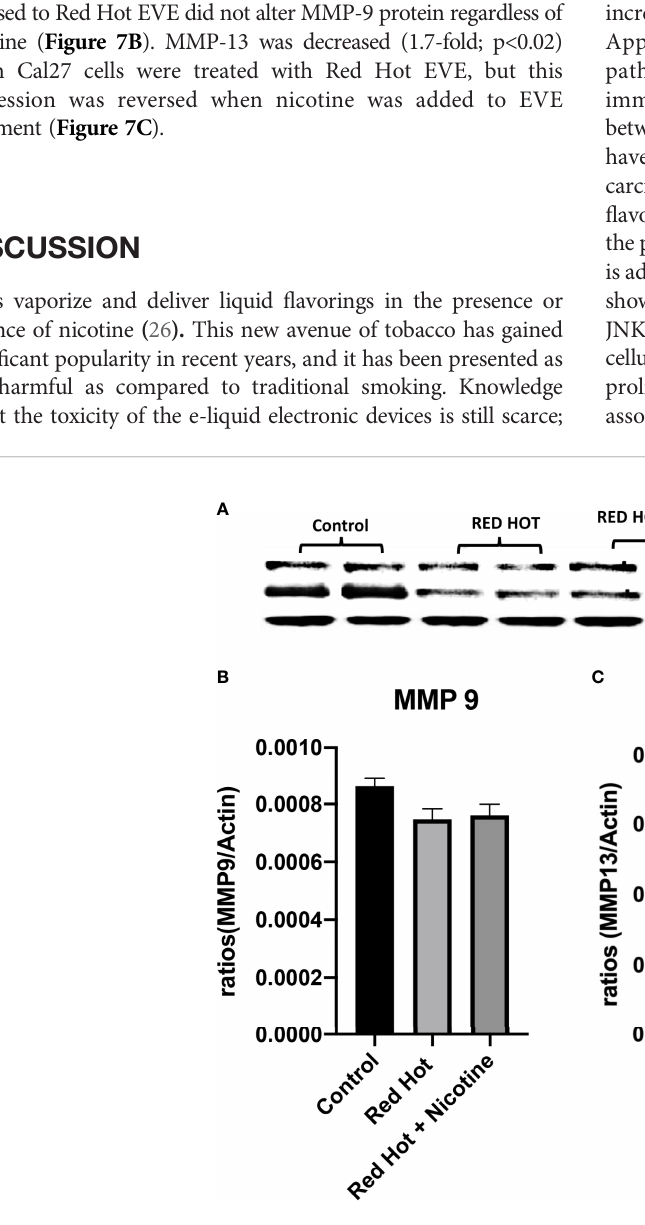
FIGURE 7 | MMP-9 and MMP-13 during Red Hot EVE treatment of Cal27 cells. A representative Cal27 MMP9 and 13 western blot picture is shown in (A) Western blot analysis showed that MMP-9 did not change when cells were treated with Red Hot EVE with or without nicotine (B) when compared to untreated control cells. MMP-13 was decreased with Red Hot EVE treatment alone (C) . Data are shown with *p ≤